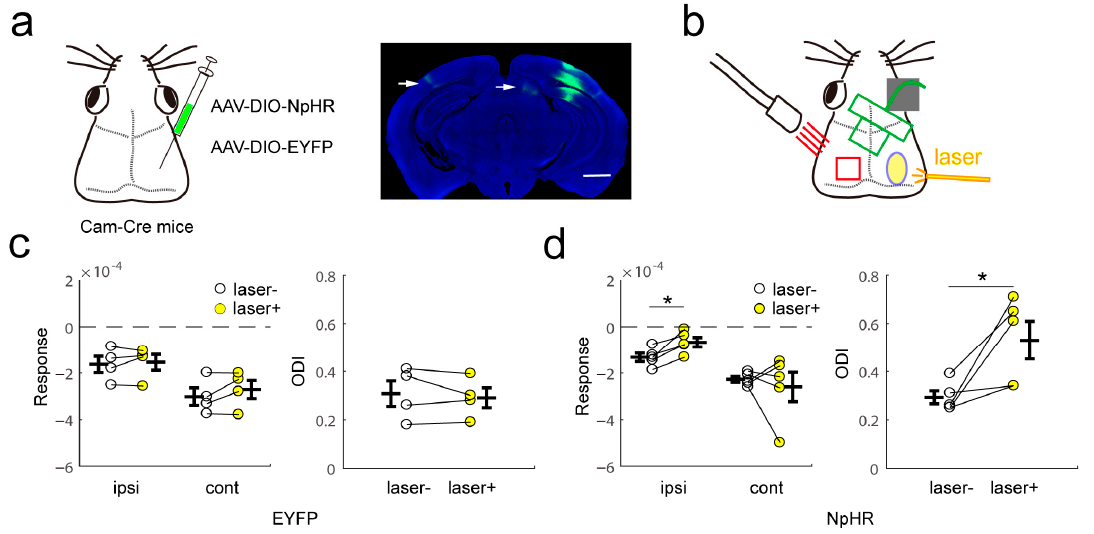
Figure 6. Ipsilateral eye response depression and ocular dominance change induced by optogenetic inhibition of contralateral excitatory neurons. ( a ) Virus injection (left) and halorhodopsin protein expression in excitatory neurons in the visual cortex (right). The scale bar is 2 mm ( right ). The white arrow shows the fiber right visual cortex. ( b ) Schematic of intrinsic signal optical imaging and laser stimuli. The intrinsic signal optical imaging recorded the signal of the left visual cortex, and light stimulation was located in the right visual cortex. ( c , d ) Response magnitude and ocular dominance index with or without laser stimuli in EYFP ( c ) and NpHR ( d ) mice (for d, ipsi, p = 0.0131, ODI, p = 0.0398, paired t-test). * p < 0.05.